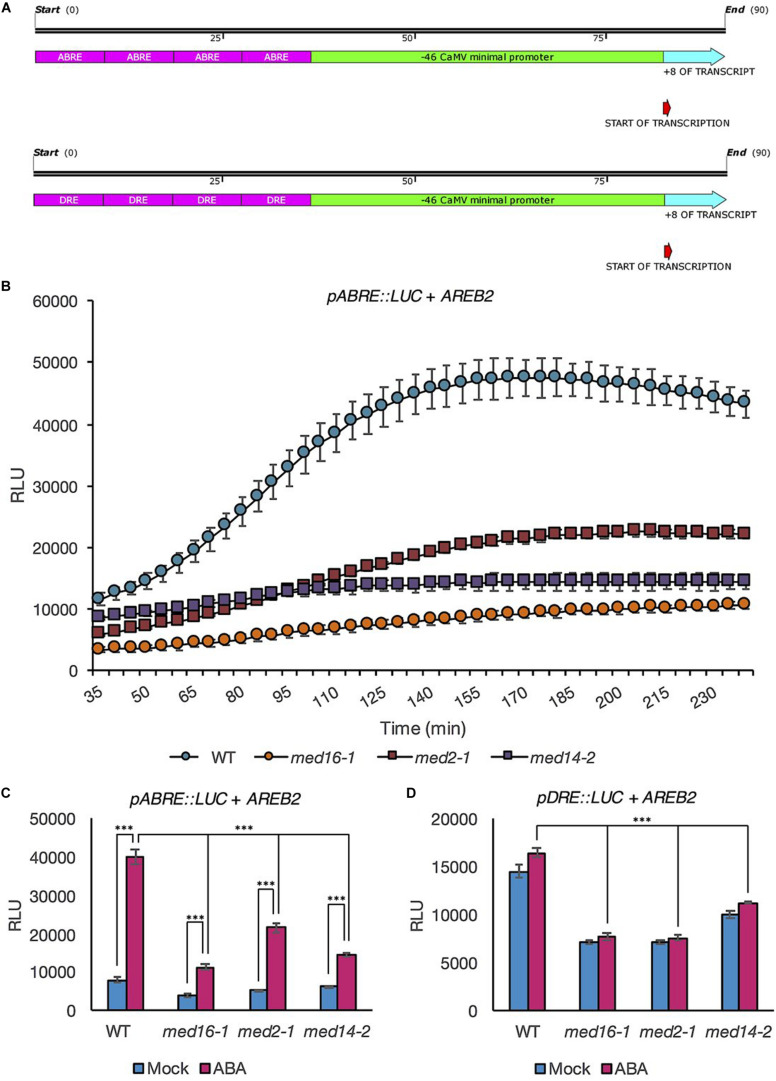
Luciferase activity driven by the ABRE and DRE promoter motifs in response to ABA is lower in mutants of the Mediator subunits MED2, MED14, and MED16 compared to the wild type. Maps showing constructs in which the coding sequence for LUC+ was fused to –46 bp minimal CaMV promoter driven by four copies of the ABRE motif and minimal promoter driven by four copies of the DRE motif (A). Protoplasts of wild type (Col-0; blue circles), med16-1 (orange circles), med2-1 (red squares), and med14-2 (purple squares) plants were transformed with the pABRE:LUC construct and AREB2. They were then treated with ABA (10 μM) and the luciferase activity was recorded for 4 h. Data shown are mean values of four repeats. Error bars represent ± one SE. One representative experiment out of three is presented (B). Luciferase activity measured in protoplasts transformed with AREB2 and a pABRE:LUC
(C) or pDRE:LUC
(D) construct and exposed to 10 μM ABA (pink bars) or mock treatment (blue bars) for 3 h. Data shown are mean values of four repeats. Error bars represent ± one SE. Asterisks denote significant difference between the indicated treatments or genotypes: ***P < 0.001. One representative experiment out of three is presented.